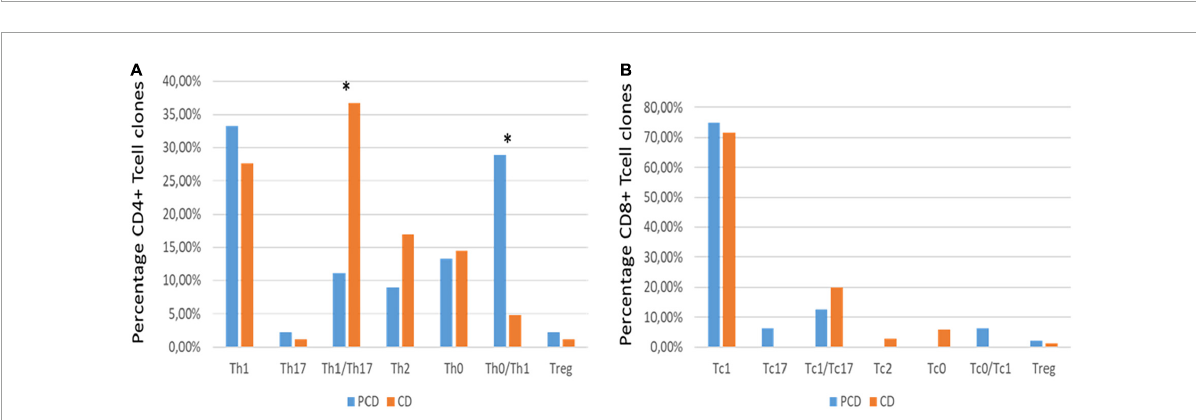
FIGURE6 (A) The cytokine phenotype percentage of CD4 + T-cell clones obtained from the duodenal mucosa of patients with atrophic CD (orange) and potential CD (blue). P -values of the intergroup comparisons were assessed with Fisher’s exact test. P -values less than 0.05 were considered statistically significant. The asterisks * represent p -values, * p < 0.05. (B) The cytokine phenotype percentage distribution of CD8 + T-cell clones obtained from the duodenal mucosa of patients with atrophic CD (orange) and potential CD